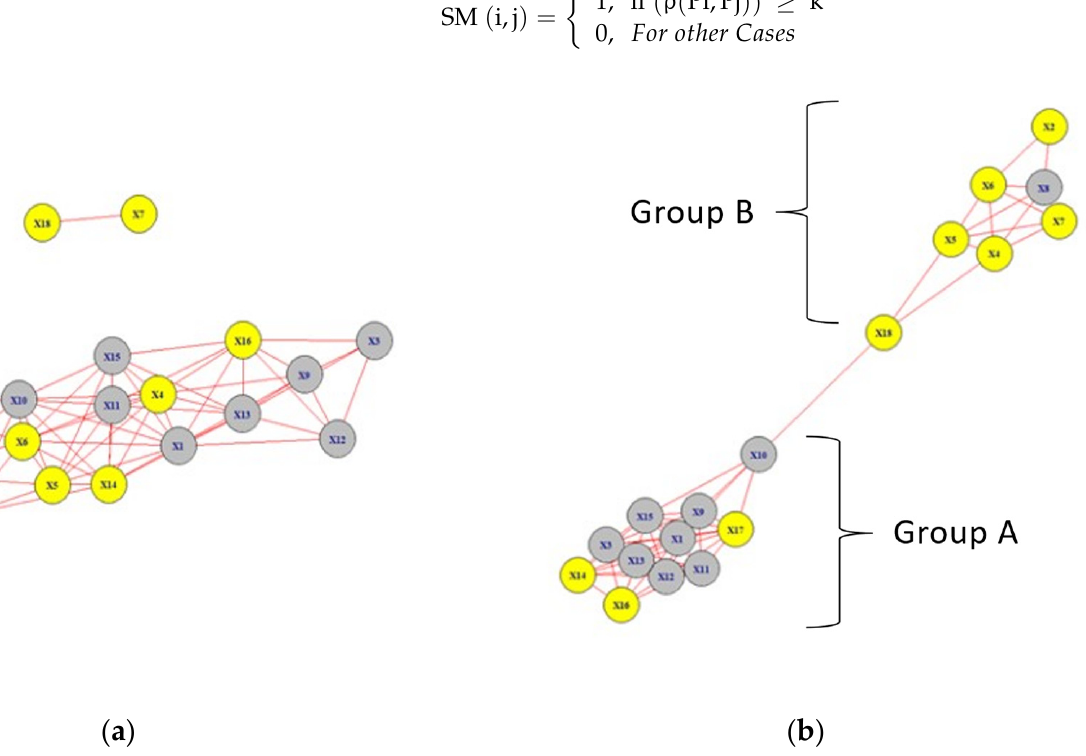
Figure 3. Network model for the needle passing task: ( a ) network model in Session 1; ( b ) network model in Session 3. Participants who had a medical background are represented by yellow nodes, while participants with a non ‐ medical background are represented by gray nodes. The network formed in Session 3 is divided into two clusters, one with higher concentration of non ‐ medical students (Group A) and other with higher concentration of medical students (Group B).